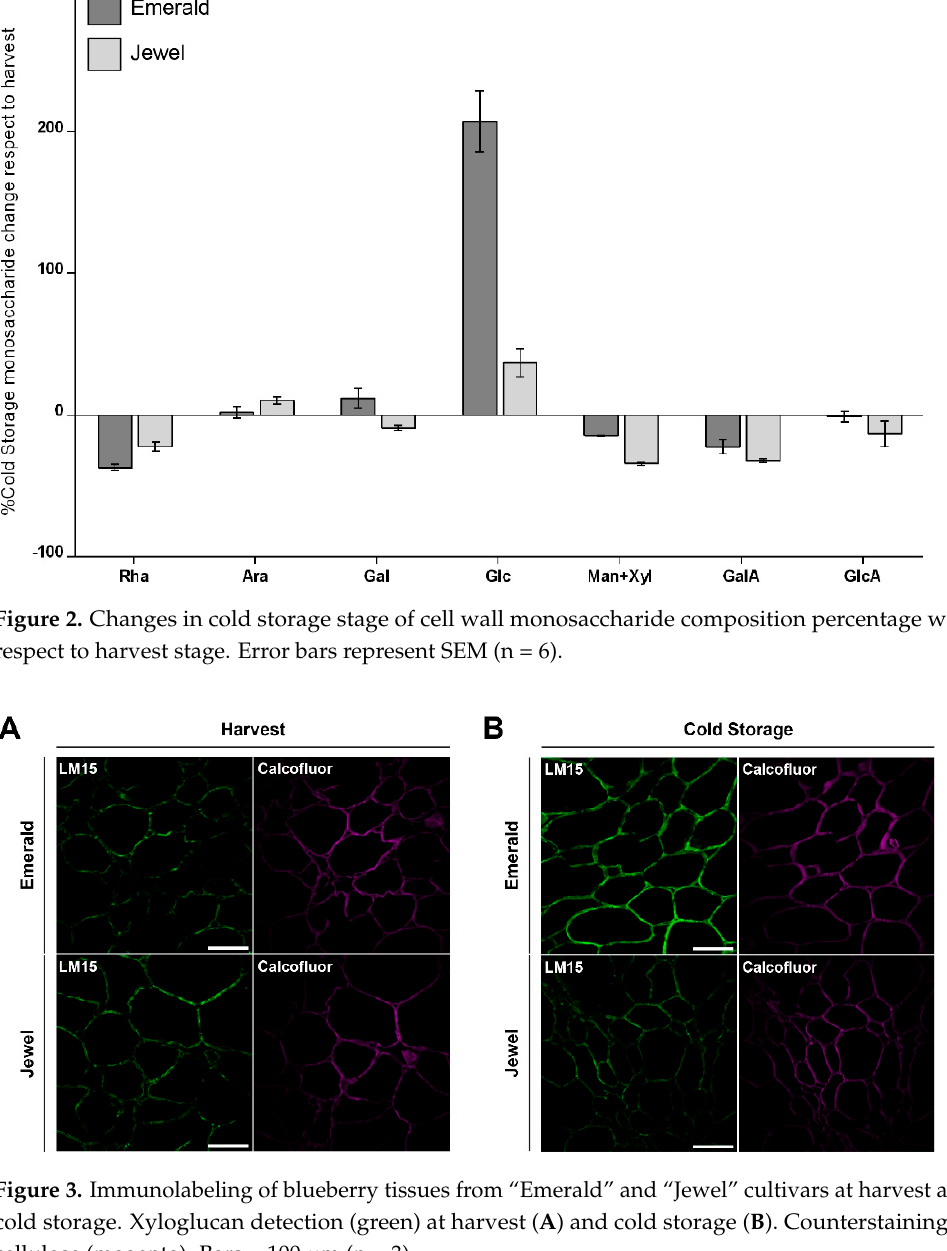
Figure 2. Changes in cold storage stage of cell wall monosaccharide composition percentage with respect to harvest stage . Error bars represent SEM (n = 6).